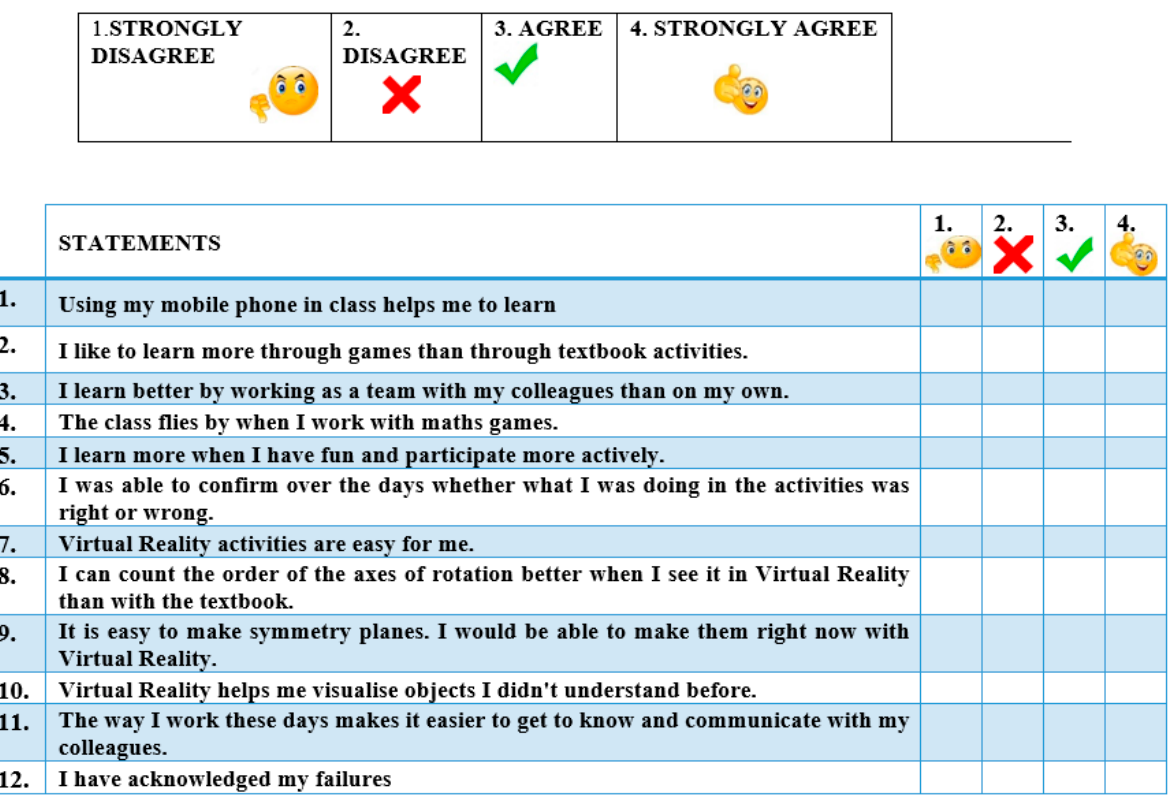
Figure A1. Questionnaire second action research cycle.